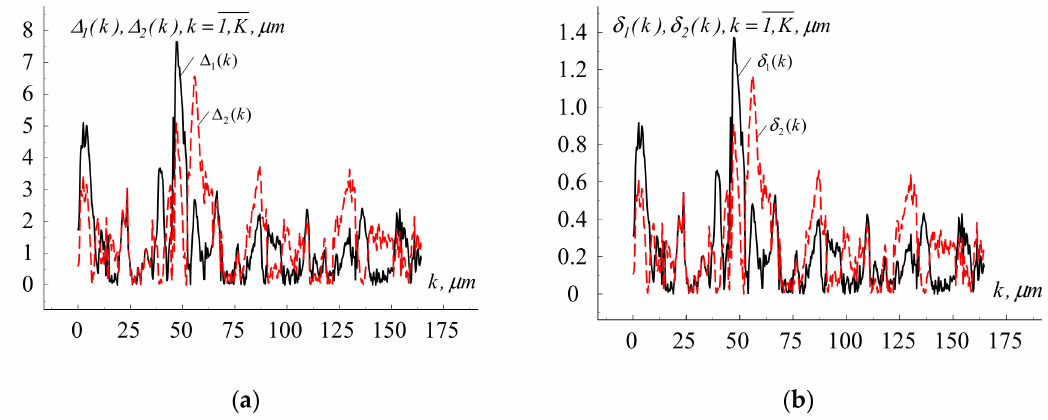
Figure 5. Fragments of the absolute and relative errors of computer modeling of the surface microrelief of